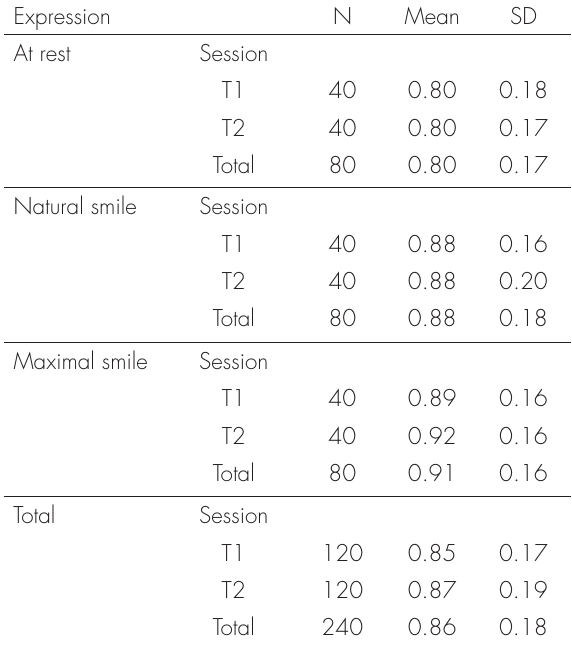
Table III. Summary statistics of overall facial asymmetry scores by expression and